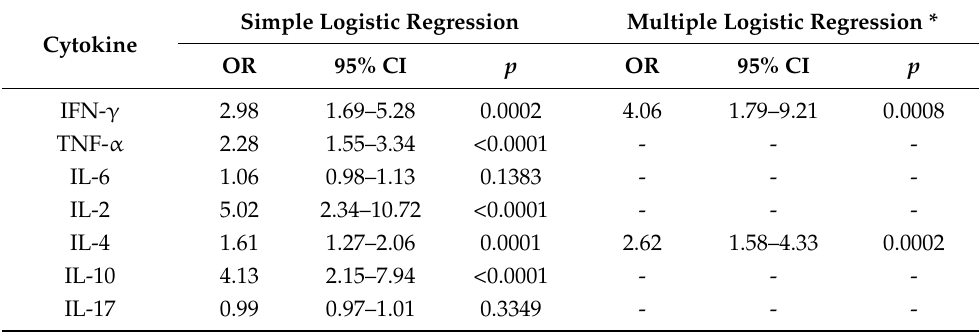
Table 4. Evaluation of cytokine levels by logistic regression between the control and TB groups. Simple Logistic Cytokine